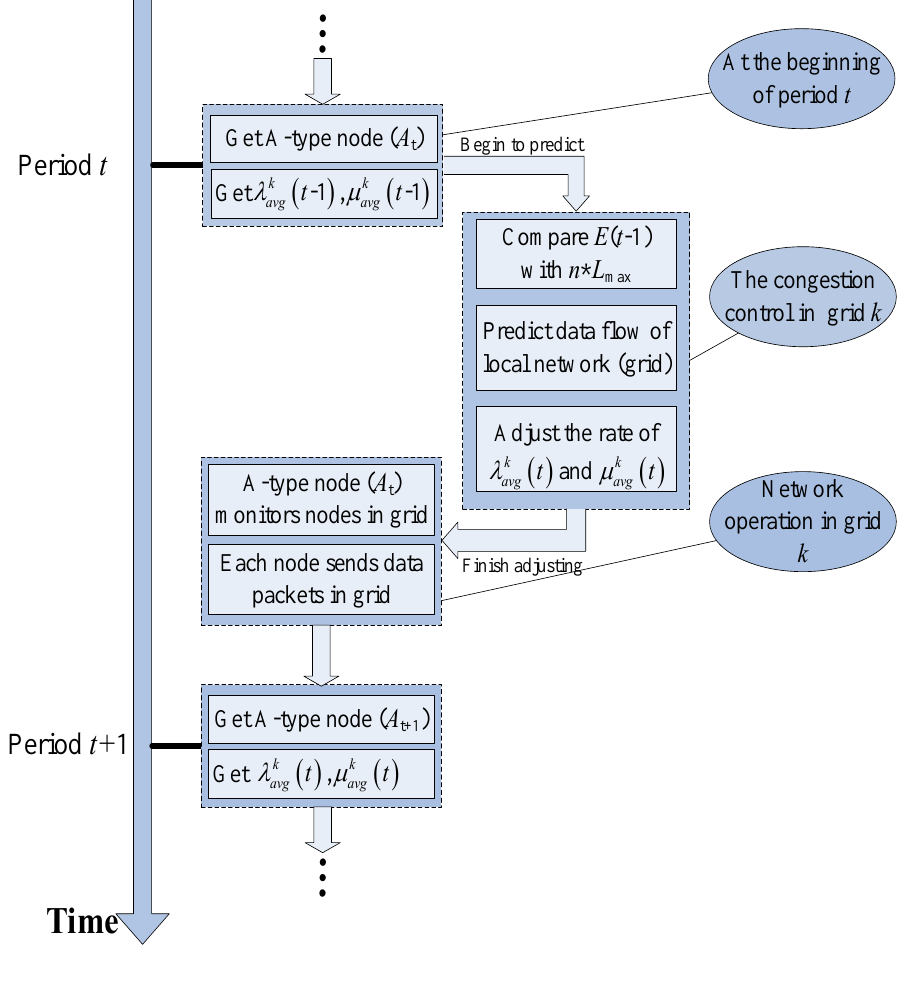
Figure 6. Flow framework of system-level control